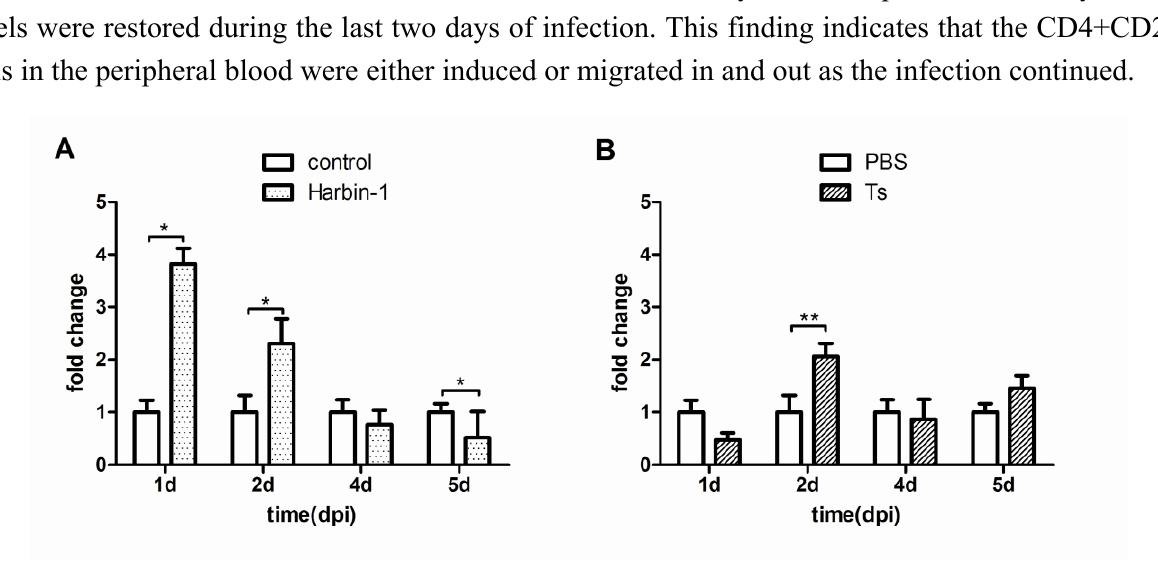
Figure 4. Changes in the level of CD4+CD25+ cells among peripheral blood lymphocytes of SPF chickens infected with the Harbin-1 or Ts strain. Note: the y-axis indicates the fold change of the IBDV group/PBS group, and the x-axis indicates the time after SPF chickens were infected with the Harbin-1 or Ts strain. Data represent mean ± SEM from 3–5 individuals. * P ≤ 0.05; ** P ≤